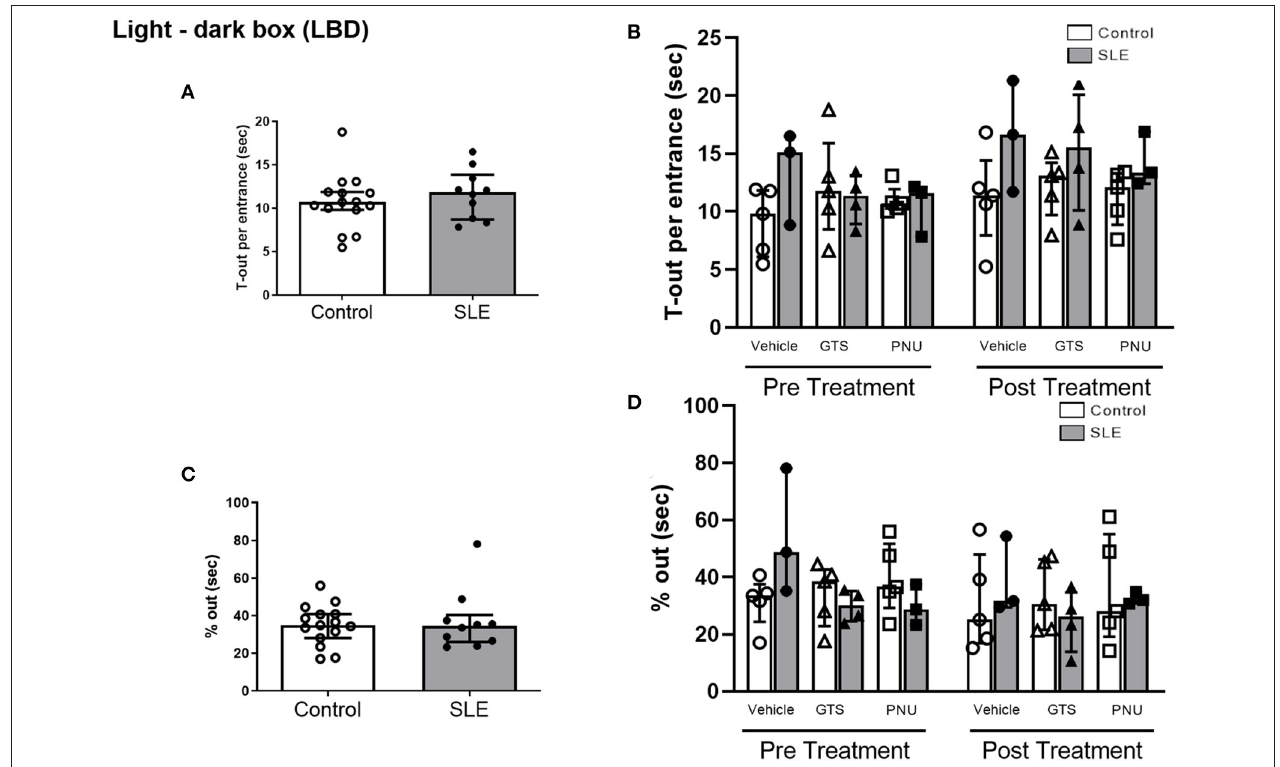
FIGURE 5 | Light-dark box test in control and SLE mice pre-treatment (A,C) and post-treatment with GTS-21 and PNU-120596 (B,D) . The pre-treatment data is a comparison between all control and all SLE mice at baseline. A t -test was used to determine significant differences between SLE and control mice pretreatment and there were no differences (A,C) . A two-way ANOVA with repeated measures was used to determine differences between all groups post treatment ( B,D ; n = 3–5 per group). The results of each ANOVA appears on the graph.